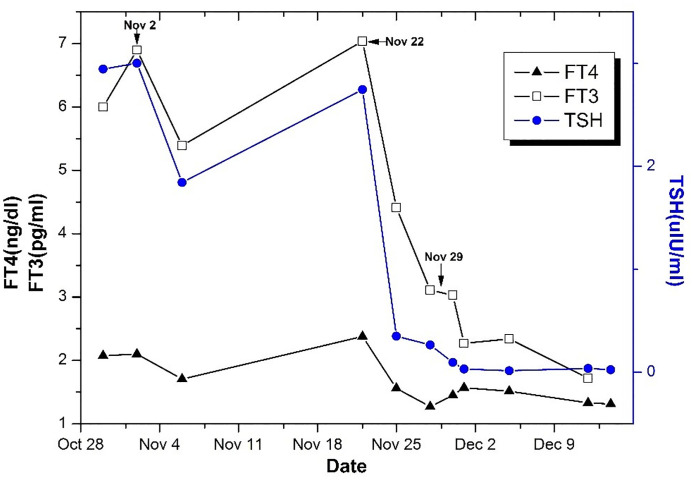
The changes of TSH, FT3, and FT4 levels in the course of treatment. On November 2, Sandostatin 0.1 mg was intramuscularly injected twice. And 0.1 mg Sandostatin was injected Q8H on November 22 for 4 days. The operation was performed on November 29.